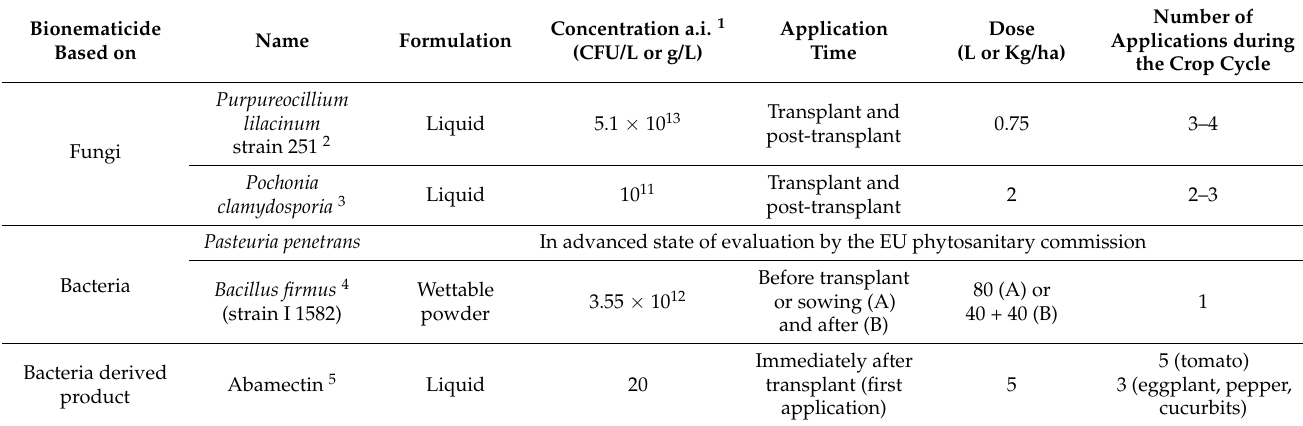
Table 3. List of bionematicides allowed for use in the C Zone of EU countries (approved for use under EC Reg. 2009/1107 according to BPDB: Bio-Pesticide Data